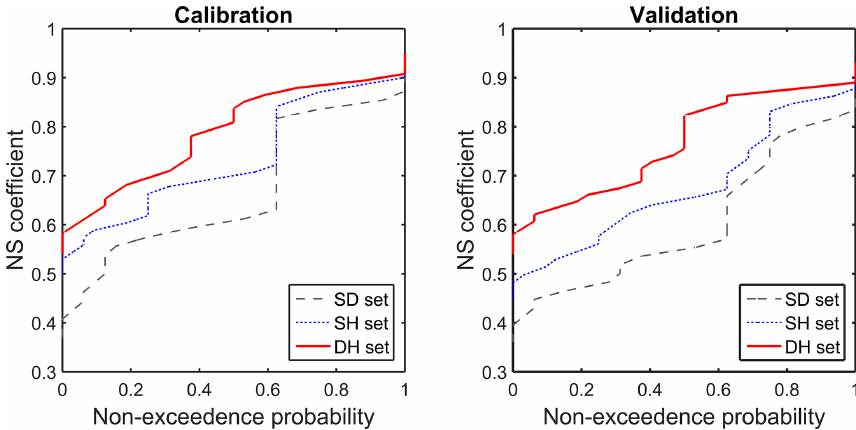
Figure 12. Cumulative distribution of the NS coefficient for model calibration using different rainfall